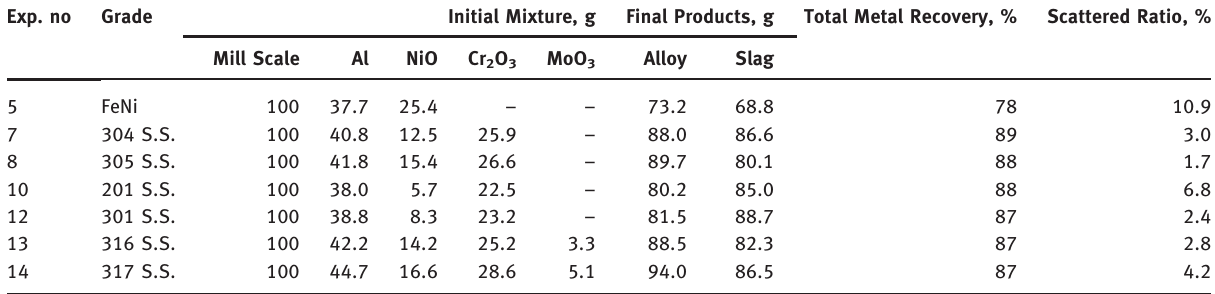
Table 3: Weight of initial mixtures, final products and total metal recovery ratios for metallothermic stainless steel alloys. Exp. no Grade